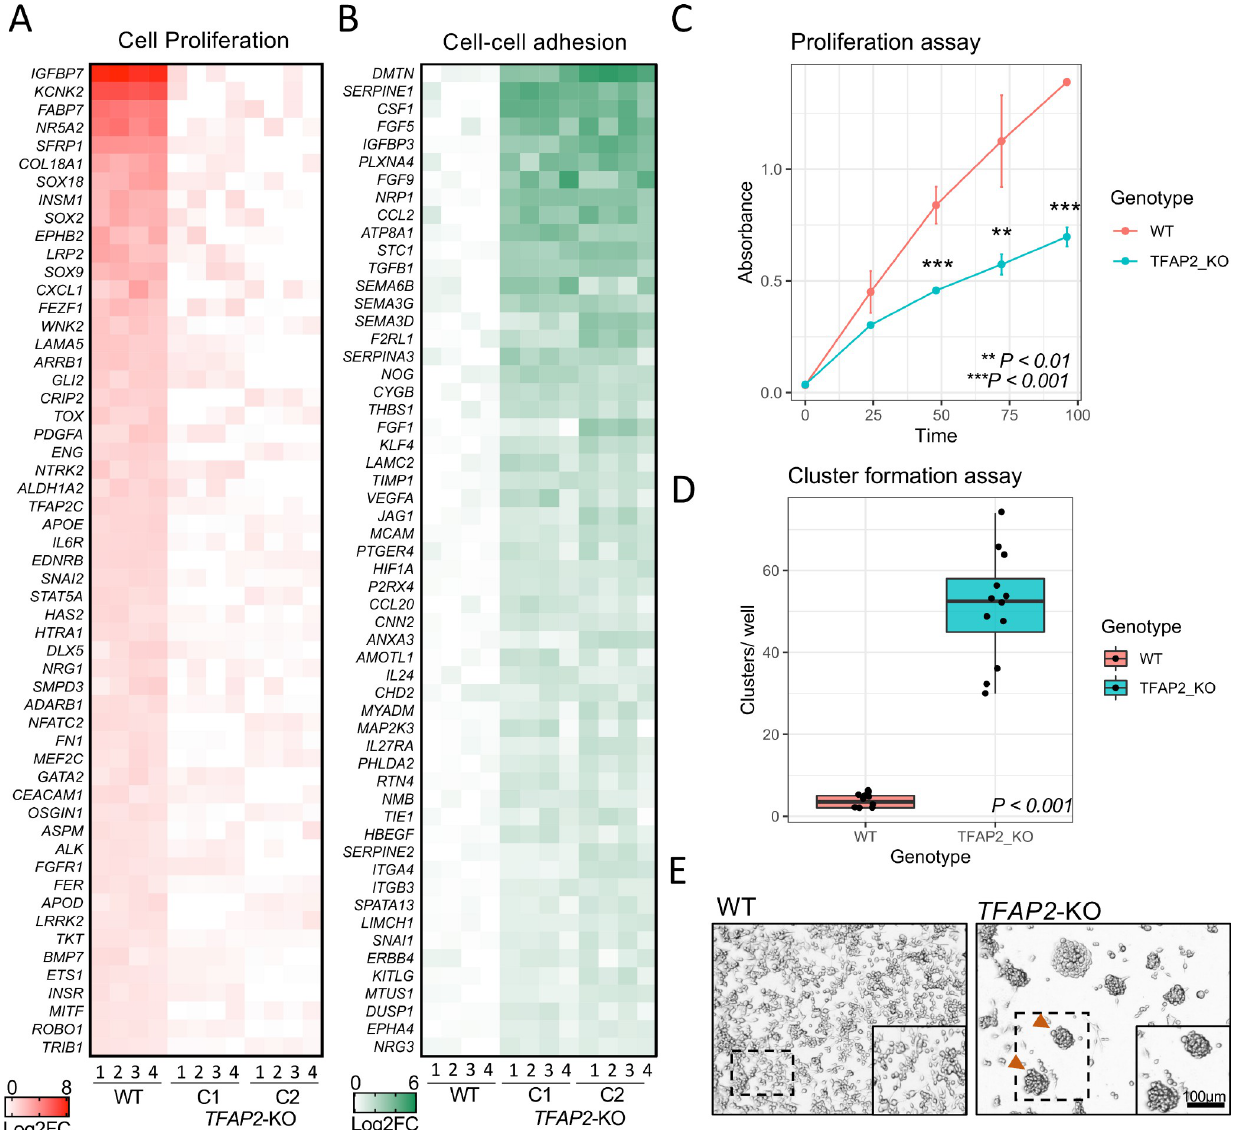
Fig 6. TFAP2 paralogs promote cell proliferation and inhibit cell-cell adhesion a melanoma cell line. ( A ) Heatmap representing the top 55 directly TFAP2-activated genes and ( B ) the top 55 directly TFAP2-inhibited genes that are associated with the GO terms cell pigmentation and cell-cell adhesion, respectively. Four replicate RNA-Seq experiments are shown for WT cells and two clones of TFAP2 -KO cells (Clone 2.12 and Clone 4.3) (FDR < 0.05). ( C ) Growth curves (mean ± SE of mean) over 100 hours of cultivation for WT and TFAP2 -KO SK-MEL-28 cells. x-axis is time and y-axis is absorbance at 450nm which is directly proportional to number of living. ( D ) Box plots representing the quantification of cluster formation on low-bind plates after 72 hours of culture (n = 12 independent experiments, p < 0.001 by Student’s t-test, plot shows mean ± SD). ( E ) Representative images of clusters formed in WT and TFAP2 -KO cells after 72